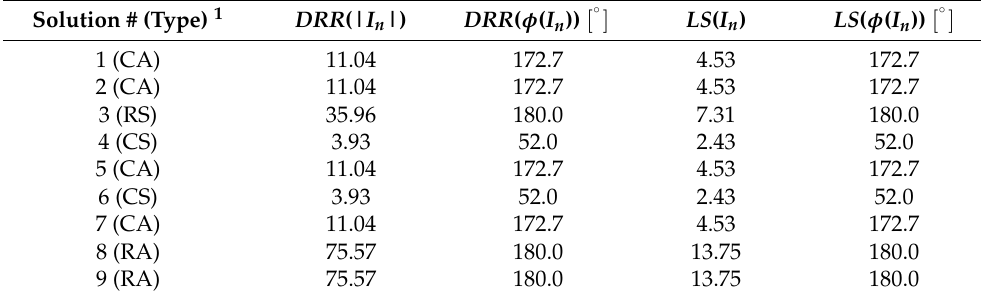
Table 1. Dynamic range ratio and local smoothness of the multiple excitations sets obtained by the initial flat-top beam pattern of Figure 3. Linear array of 12 elements.